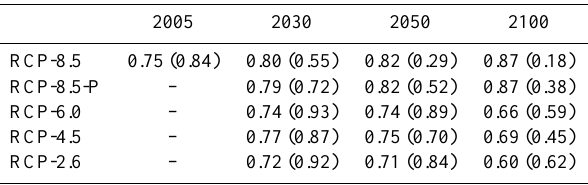
Table 2. Global, tropospheric average ozone column density ( × 10 18 moleculescm − 2 ) from the base model runs, and the per- centage reduction in column density when megacity emissions are removed (in